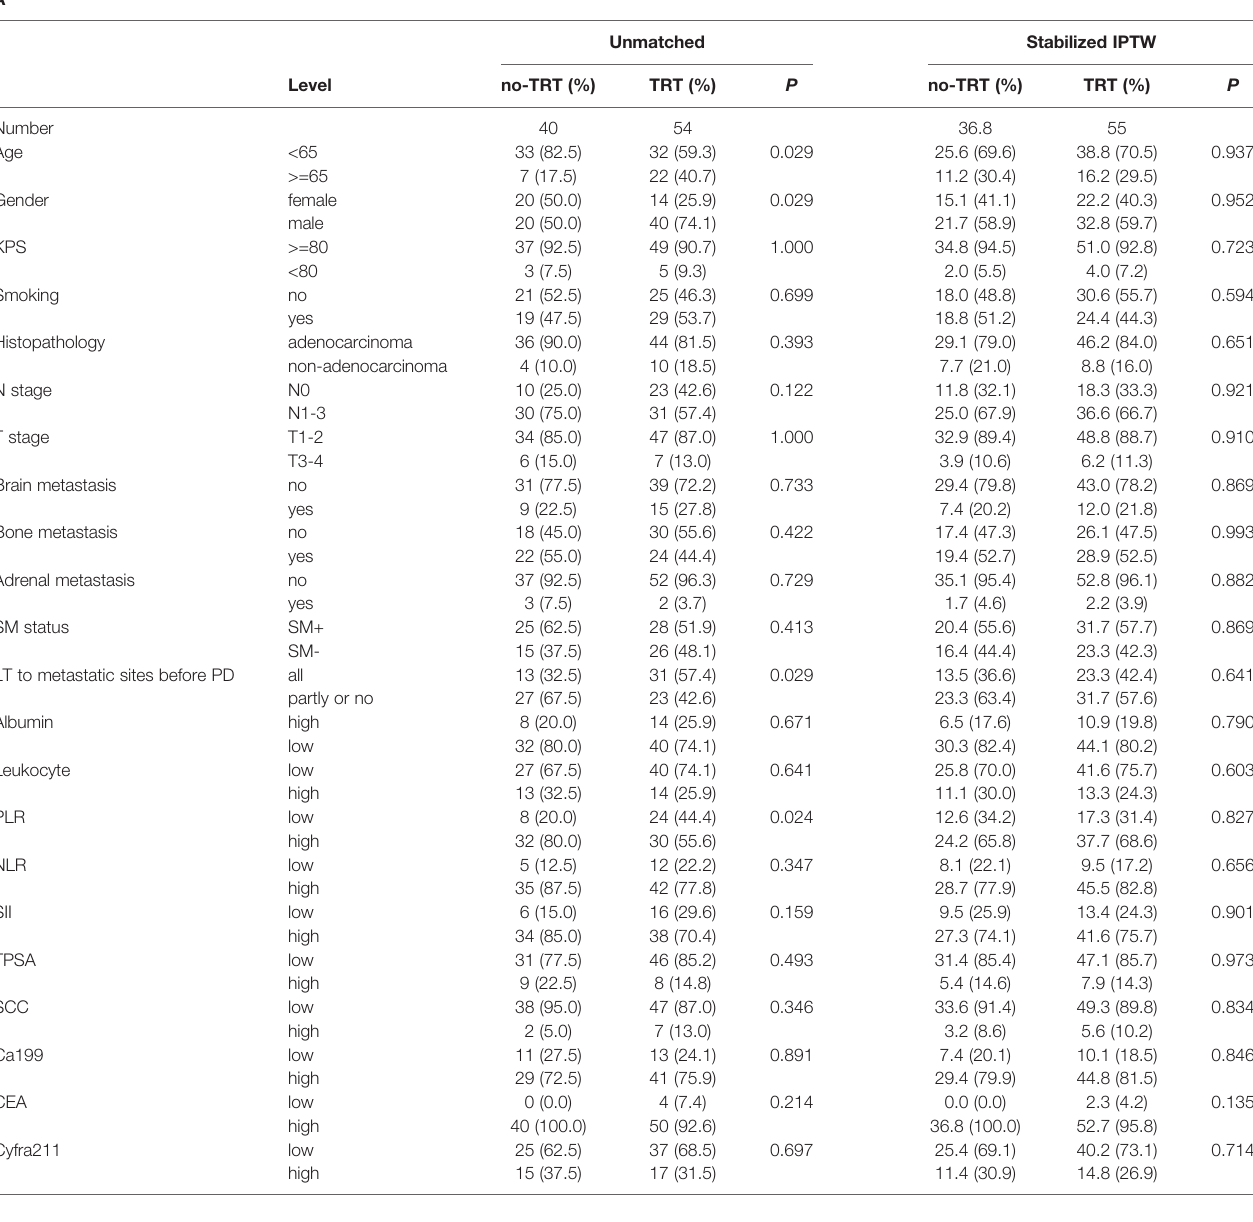
TABLE 6 | Comparison of clinical characteristics of patients in no-TRT and TRT